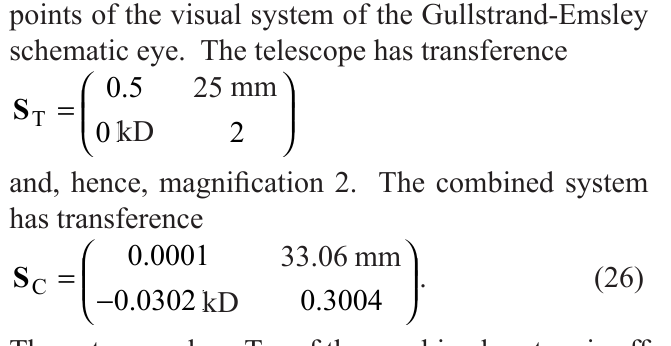
Figure 9 Effect of an afocal telescope of magnification 2 in front of the Gullstrand-Emsley schematic eye. The entrance plane of the telescope T C0 is off the figure to the left as are the incident focal point F C0 and the emergent principal point P C1 of the com- bined system of telescope and visual system. The horizontal red and green lines have been drawn only between T 0 and T 1